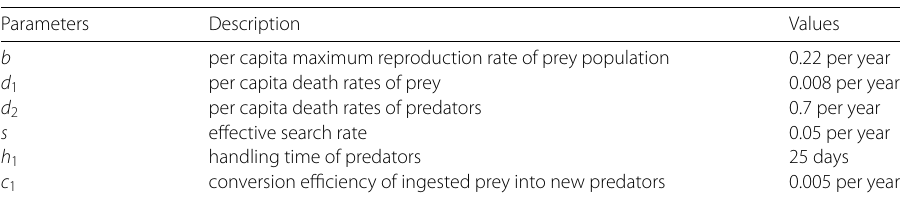
Table 1 The parameters of the model Parameters